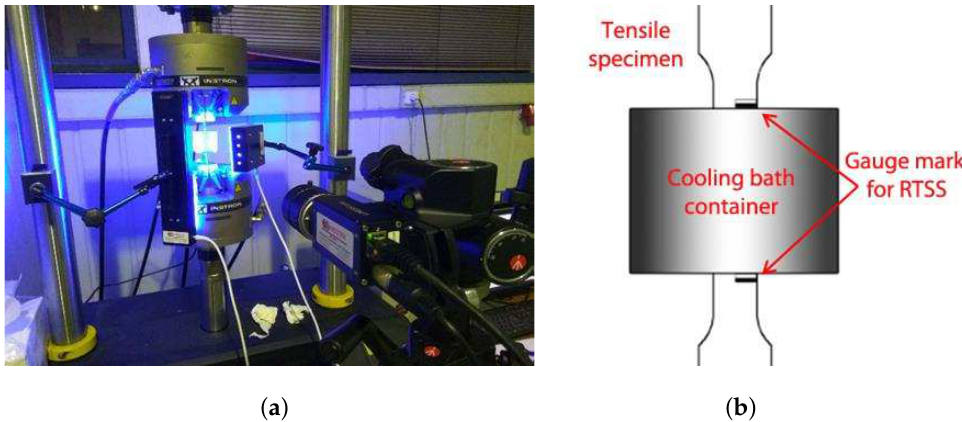
Figure 4. Experimental setup for the evaluation of M σ s temperature. ( a ) RTSS Video-extensometersetup, ( b ) Graphical representation of specimen setup.